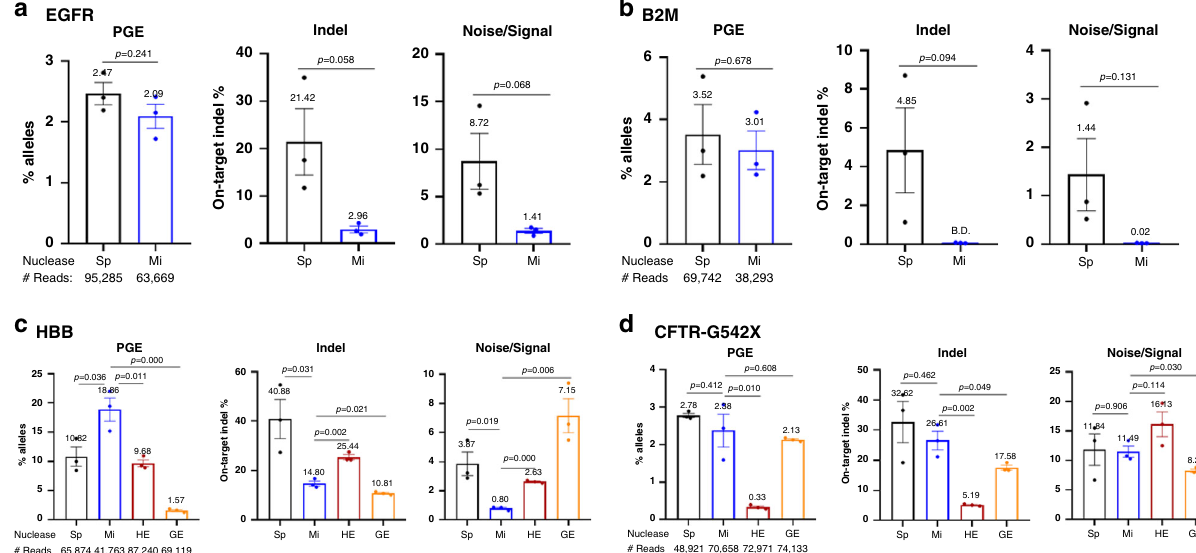
Fig. 4 Effects of miCas9 on ss-PGE applications. a PGE rates, on-target indel rates, and the noise/signal ratio at EGFR by spCas9 and miCas9 in human iPSCs. b PGE rates, on-target indel rates, and noise/signal ratio at B2M by spCas9 and miCas9 in human iPSCs. c PGE rates, on-target indel rates, and noise/signal ratio at HBB by different nucleases in human iPSCs. d PGE rates, on-target indel rates, and noise/signal ratio at CFTR-G542 by different nucleases in human iPSCs. Sp: spCas9, Mi: miCas9, HE: Cas9-HE, GE: Cas9-GE. # Reads: Average amplicon reads per sample. Three